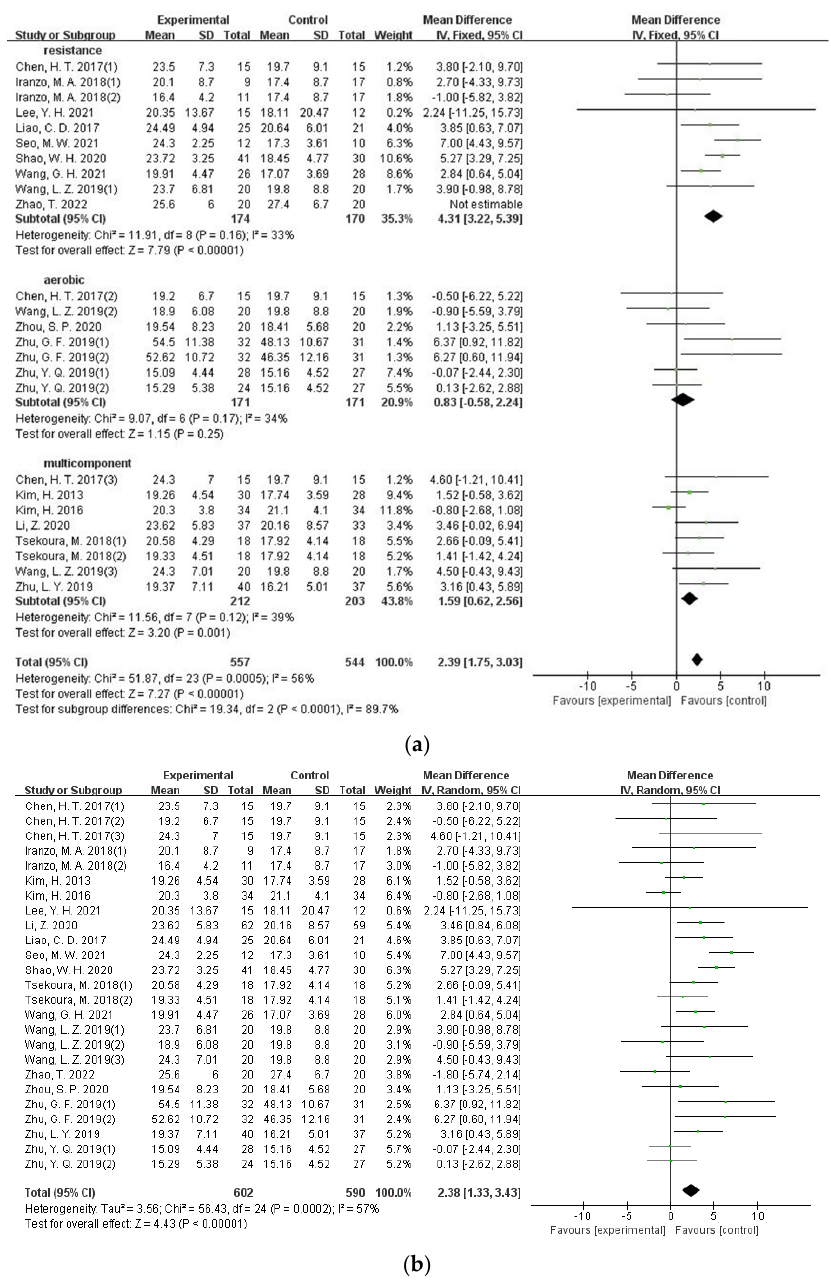
Figure 3. ( a ) Forest plot of the effectiveness of exercise interventions for grip strength improvement according to different exercise types; ( b ) forest plot of the effectiveness of exercise interventions for grip strength improvement in older adults with sarcopenia.